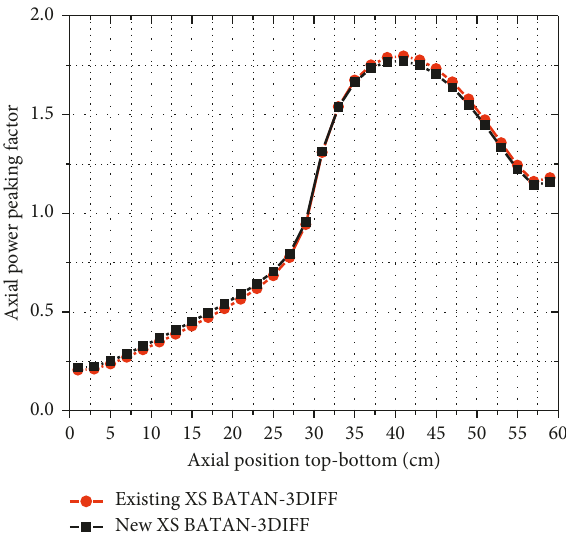
Figure 6: Calculated axial power peaking factor. Figure 7: Calculated axial temperature distribution on RSG-GAS